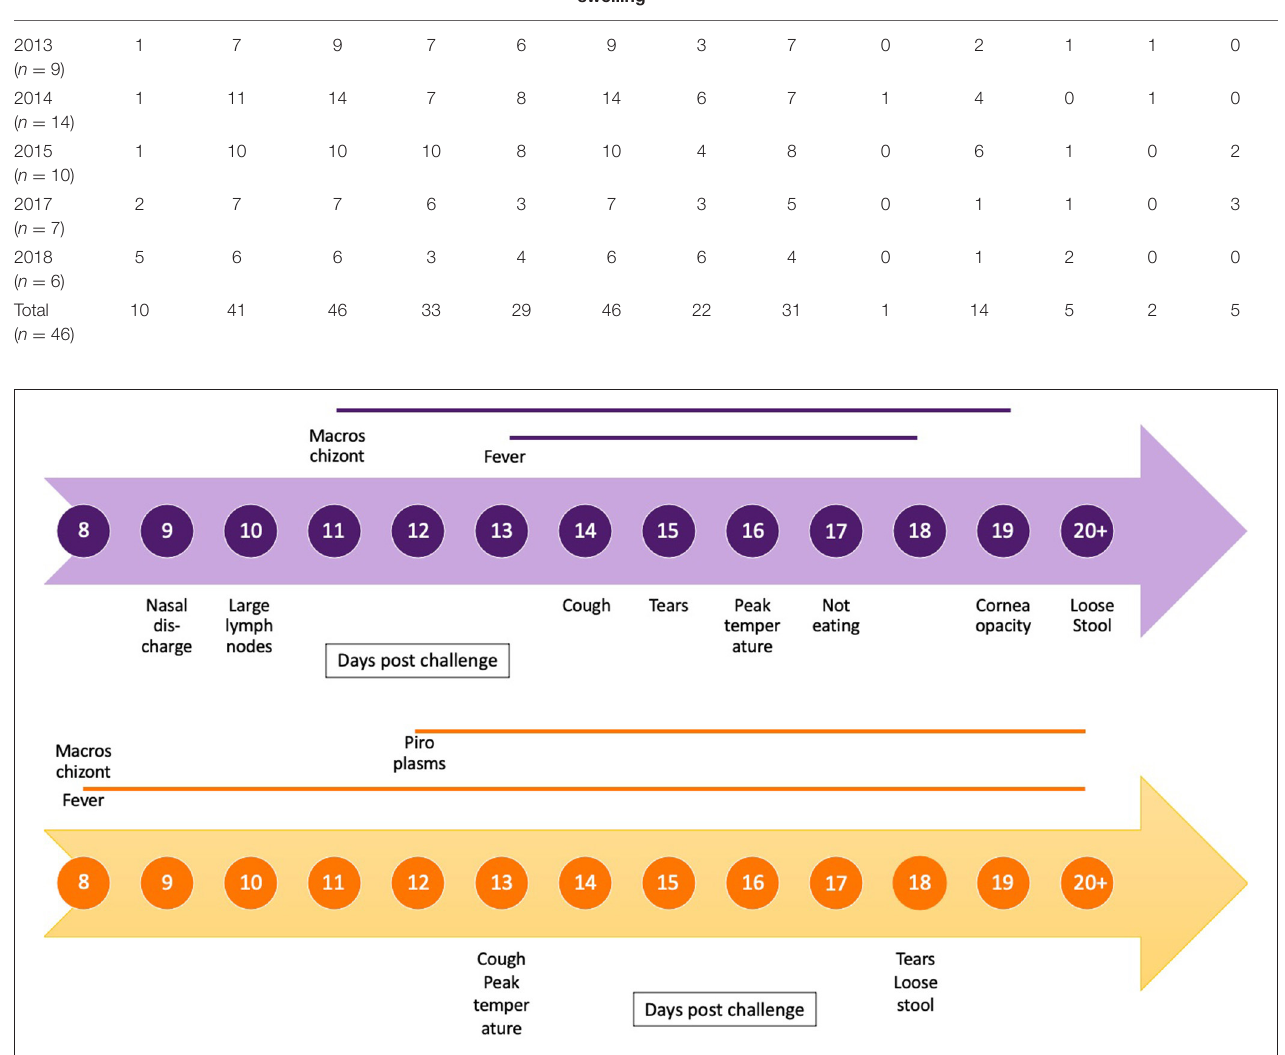
FIGURE 4 | Timeline of clinical progression of corridor disease using mean day post-exposure for onset and duration of clinical signs and presence and duration of macroschizonts in lymph node aspirates (blue) compared with timeline of clinical progression of East Coast fever (orange) as described by Jura and Losos (10).